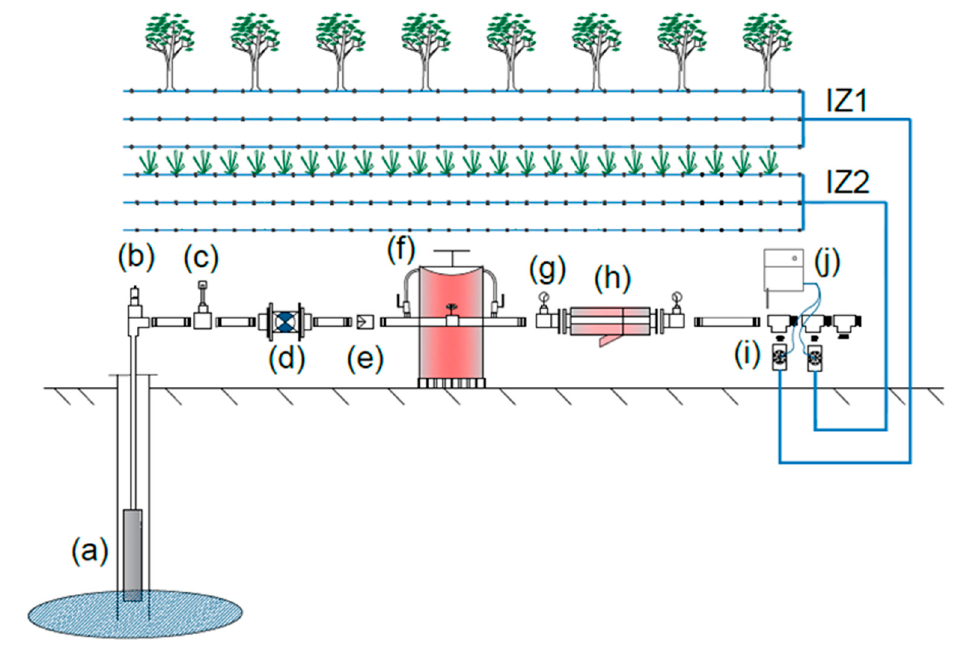
Figure 2. Layout components of a modernized pressurized irrigation system (PIS); supply pump ( a ); central control head unit (( b ) to ( h )); pressure regulator and pressure relieve valve ( b ); air release valve ( c ); water meter ( d ); one-way valve or a non-return valve ( e ); injection tank ( f ); pressure gauge ( g ); filtration unit ( h ); manifold and electric valves ( i ); irrigation zone 1 and 2 irrigating crops with different water needs (IZ1,IZ2); irrigation controller ( j ).